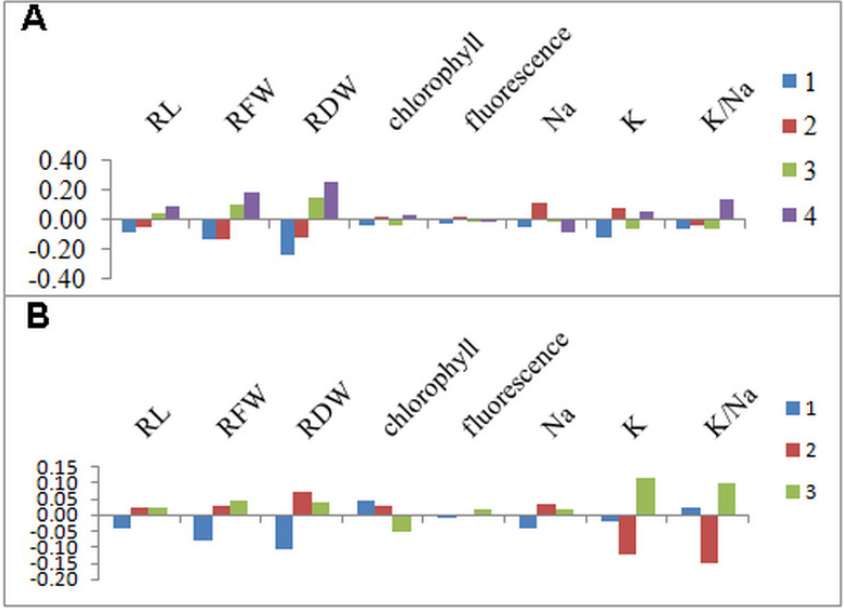
Fig. 2. The average deviation of the mean cluster: A. Control B. 140